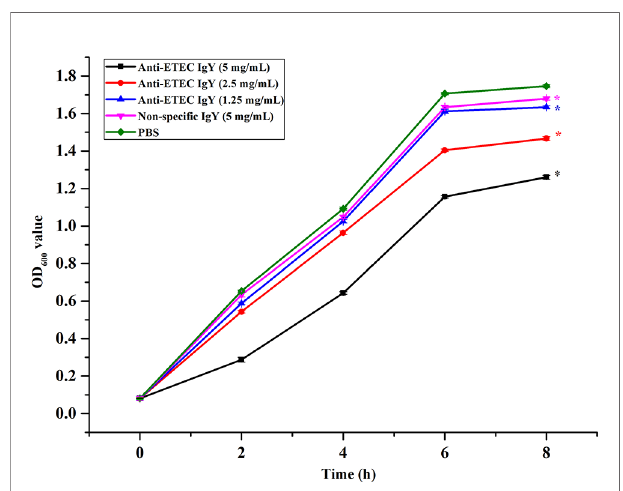
FIGURE 1 | Growth inhibition curves of ETEC K88 treated with different doses of anti-ETEC IgY. Values are expressed as the mean ± SEM (n = 3). * P < 0.05 compared to PBS